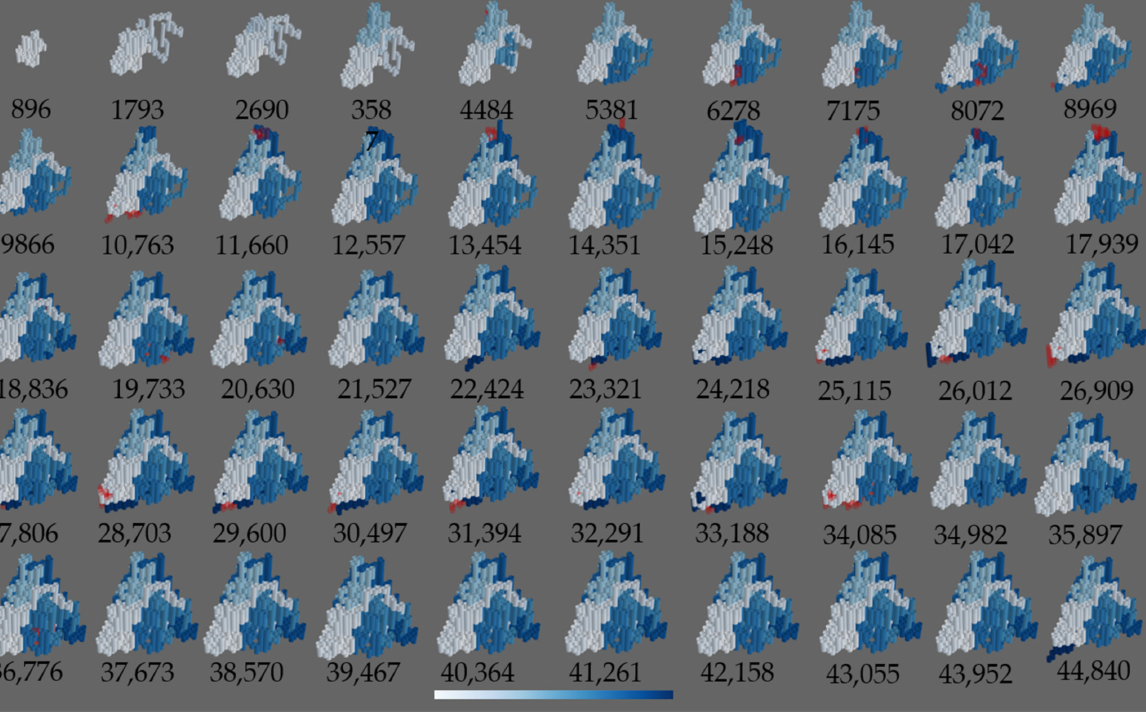
Figure 11. Scaffold growth visualization using a blue color map for right tetrahedron in Figure 6a with a total length of 7728 bp, where the scaffold is represented as cylinders. The total iteration of the shape annealing schedule is divided equally into 50 steps, where an image is generated at each step. The blue color map starts from a light blue tint, which represents the beginning of the scaffold, to dark blue tint, which represents the end of the scaffold. Below each image is the iteration number during the annealing schedule. The transparent red cylinders signify the application of the reversal